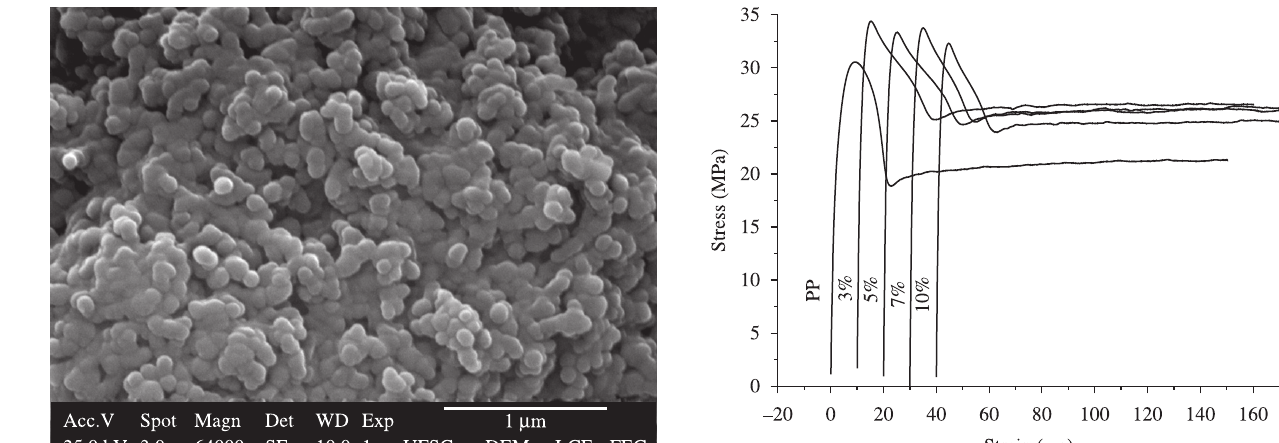
Figure 4. Stress- strain curves of neat PP and PP/CaCO Curves were shifted in the